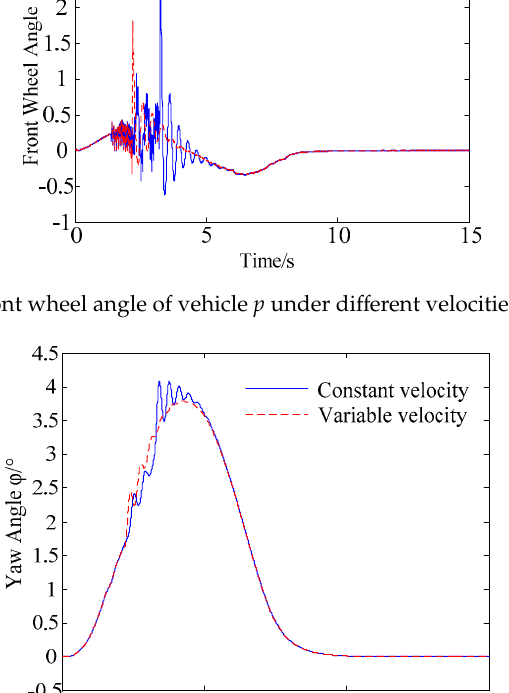
Figure 30. Yaw angle of vehicle p under di ff erent velocities of vehicle q .